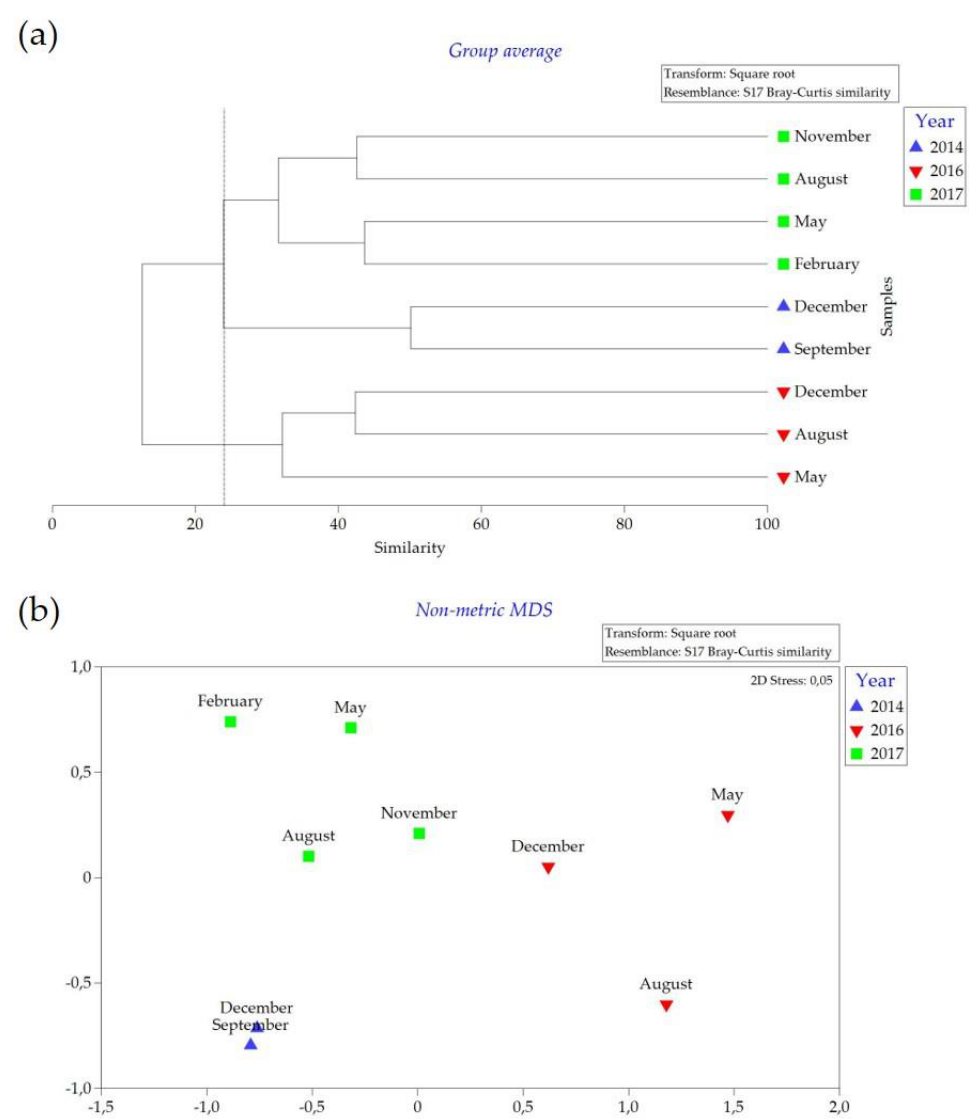
Figure 2. ( a ) Dendrogram and ( b ) non-metric multidimensional scaling (nMDS) plots of aquatic invertebrate taxa collected during sampling surveys in 2014 (predrought), 2016 (drought) and 2017 (recovery) in Lake Nyamithi.